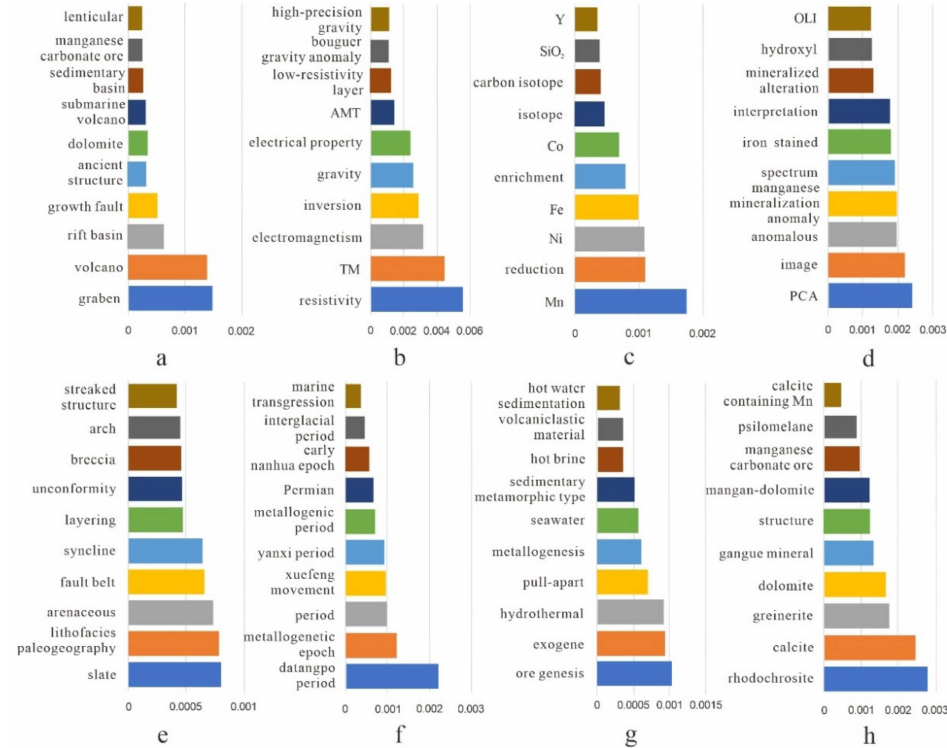
Figure 8. TF-IDF statistical graph of Songtao-Huayuan manganese ore: ( a ) geological prospect- ing, ( b ) geophysical prospecting, ( c ) geochemical prospecting, ( d ) remote sensing, ( e ) metallogenic background, ( f ) metallogenic period, ( g ) genetic type, and ( h ) mineralization